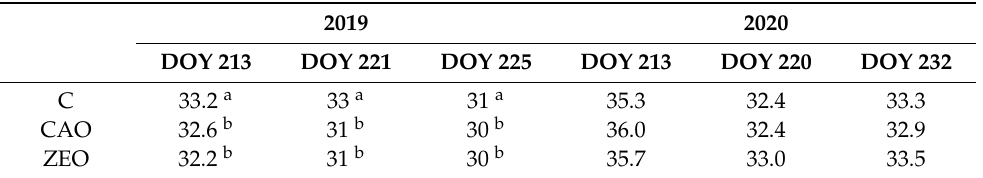
Table 2. Single leaf temperatures measured using an infrared thermometer in the 2019 and 2020 seasons. Readings were taken on three well-exposed leaves per vine. Different letters within a column indicate significant differences as calculated using the Tukey statistical analysis test ( p ≤ 0.05).